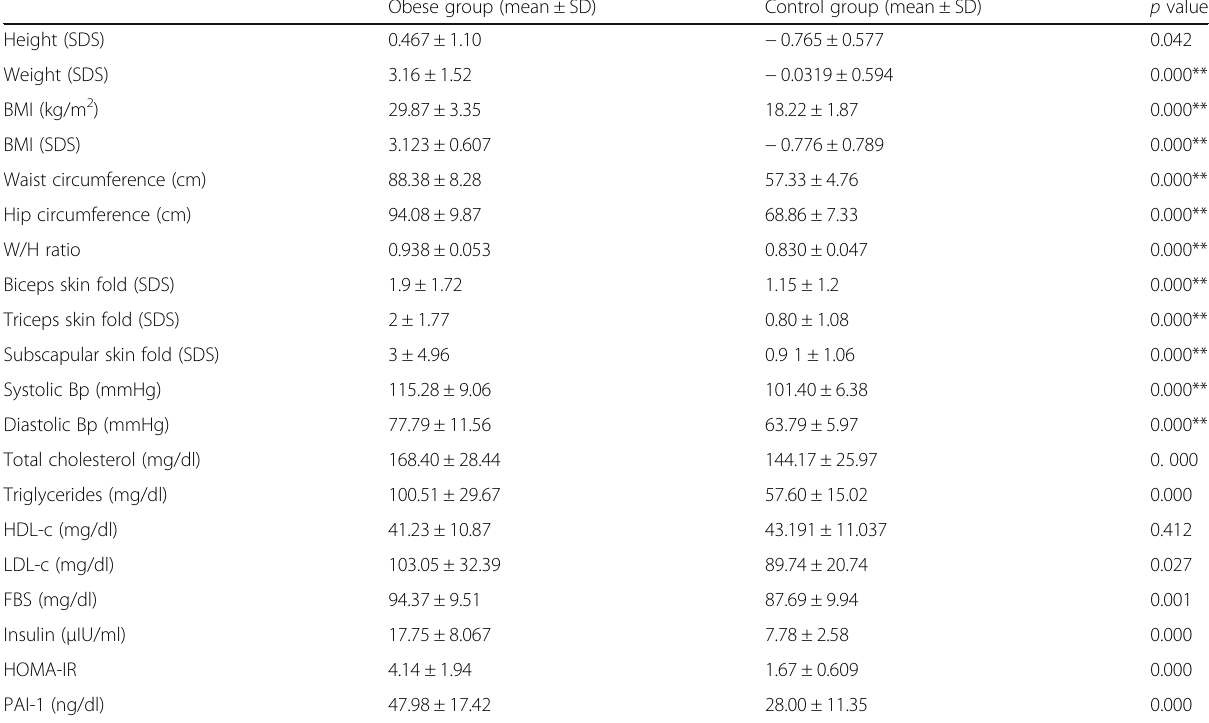
Table 1 Anthropometric, clinical, and laboratory data in the obese and control groups Obese group (mean ±